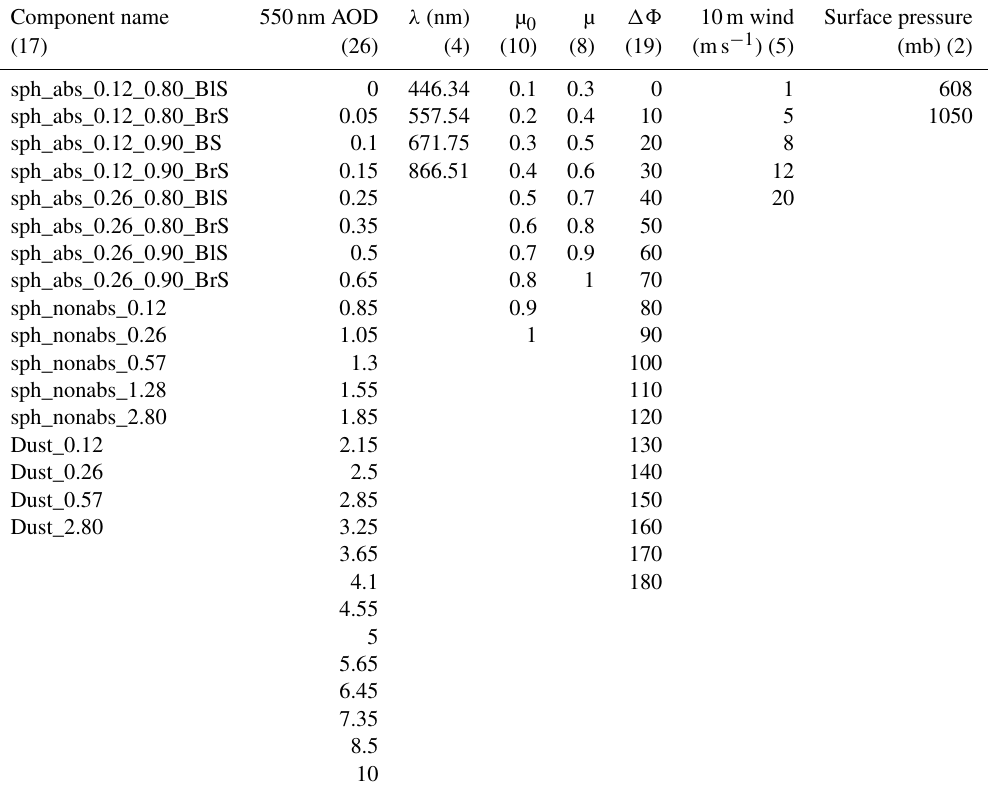
Table 2. Updated LUT values and dimensionality. Each column lists the values of the variable in the heading that are included in the LUT. The number of values is given in parentheses at the top, The overall dimensionality of the LUT is eight, although it is broken up into a seven- dimensional over-land LUT (no wind speed dimension; 5 . 4 × 10 6 elements) and a seven-dimensional over-water LUT (surface pressure assumed to be 1013.25mb; 1 . 34 × 10 7